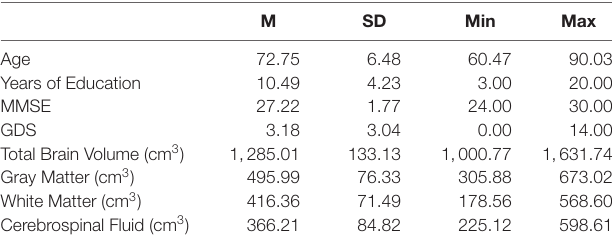
TABLE 1 | Means, standard deviations and ranges of age, MMSE scores, years of education, GDS scores, and brain volume